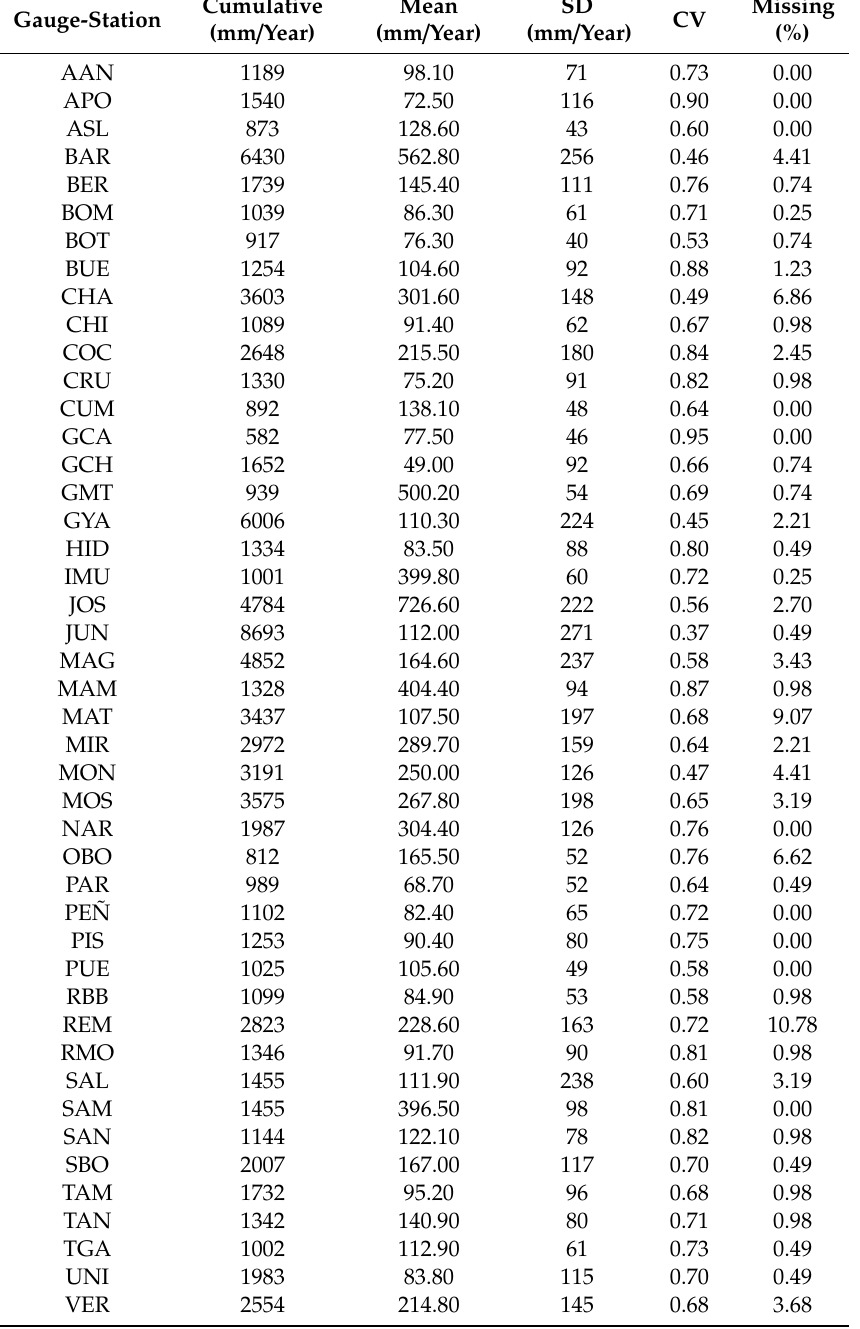
Table 1. Description of the monthly rainfall dataset